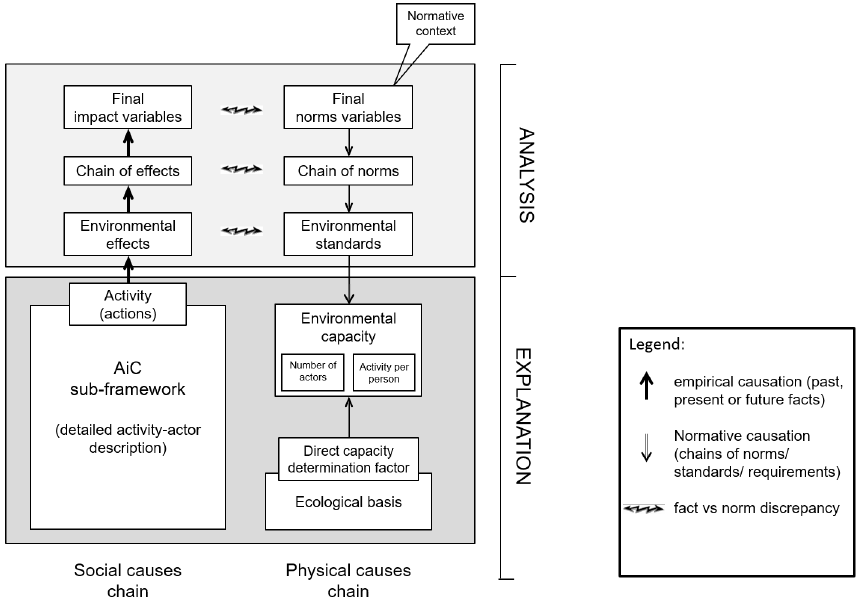
Figure 2. Problem-in-Context framework (PiC), adapted from